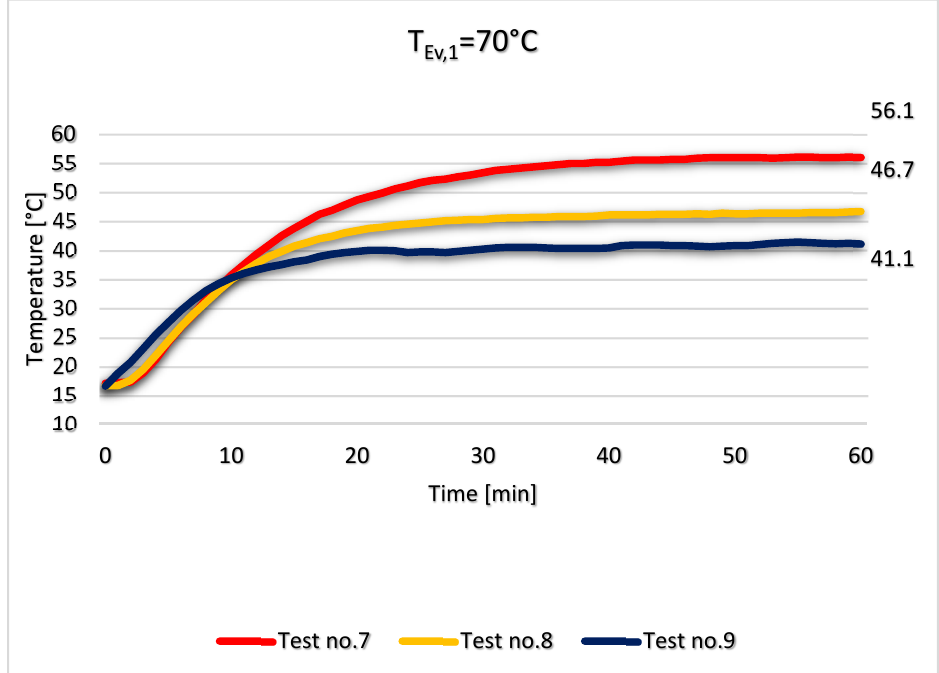
Figure 6. The variation of temperature at the outlet of the condenser for tests no. 4, 5, 6. The tests were repeated for the same volume flow rates but this time with the temperature of the primary agent of 70 °C. As we can observe in Figure 7, the temperature of the secondary agent after 60 min was 56.1 °C for case no. 7, 46.7 °C for case no. 8 and 41.1 °C for case no. 9. Again, the amount of heat recovered in the first 10 min does not depend on the volume flow rate of the secondary agent. After 10 min, the Δ T between the inlet and the outlet of the condenser is about 18.5 °C for all three cases (Figure 7).